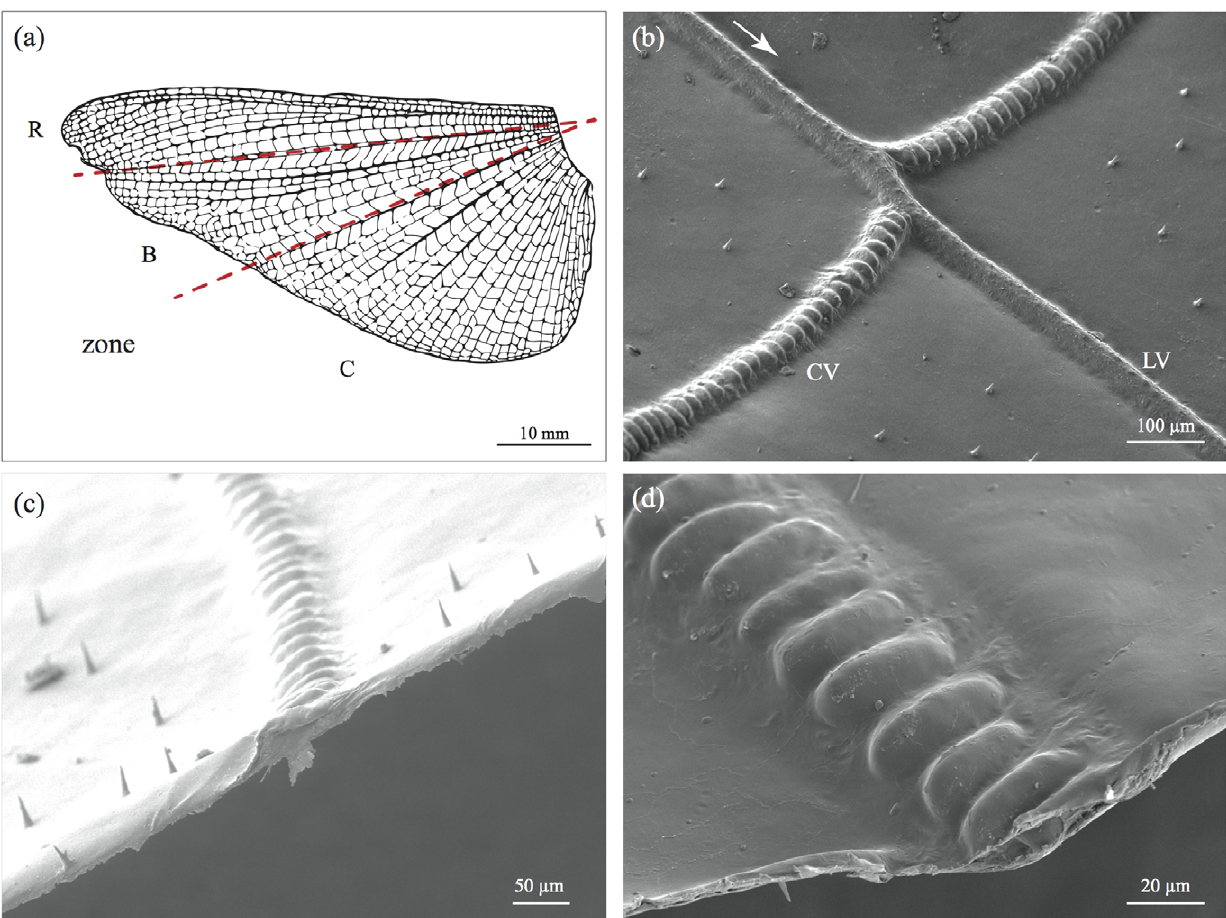
Figure 1. Morphology ofS.gregaria hind wings. (a) Schematic illustration of the three wing zones R, B and C used for the experiments (adapted from [8]). (b) Longitudinal veins (LV) with branching cross veins (CV). Towards the edge of the hind wing the two types of veins show a different morphological structure. Whilst the longitudinal veins mostly show a circular to elliptical cross section, the cross veins show an annulated pattern. (c) Cross section through the wing membrane and a cross-vein. Note that the cutting edge of the wing membrane slightly ‘‘crumpled’’ during the desiccation. (d) Close-up of a cross-vein, showing the compartment-like annulated structure.